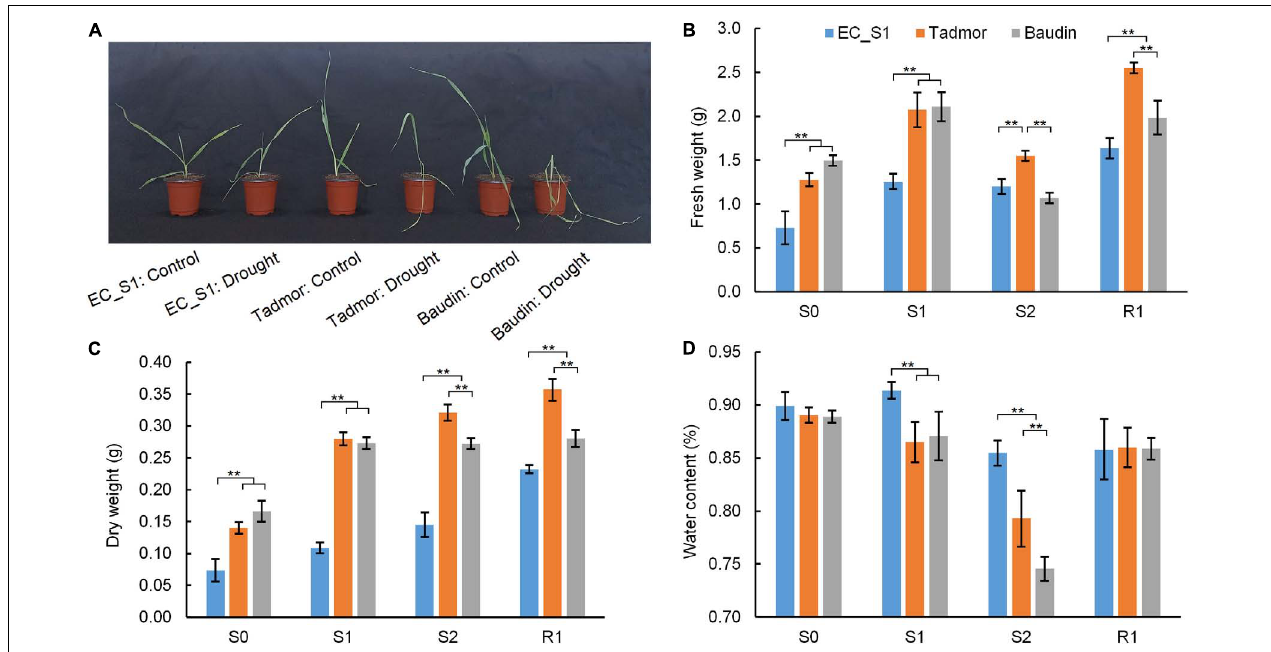
FIGURE 1 | The morphology and biomass of EC_S1, Tadmor and Baudin after drought treatment for 16 d. (A) Photo of plants under control and drought treatment conditions; (B) fresh weight; (C) dry weight; (D) water content. S0: drought for 0 day; S1: drought for 14 days; S2: drought for 16 d; R1: drought for 18 days and rewatered for 1 day. * and ** indicate significance levels at P ≤ 0.05 and 0.01, respectively ( n = 3 independent